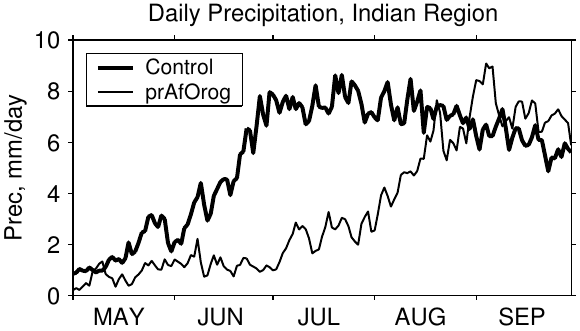
Fig. 15. Evolution of rainfall in the control and prAfOrog simula- tions.